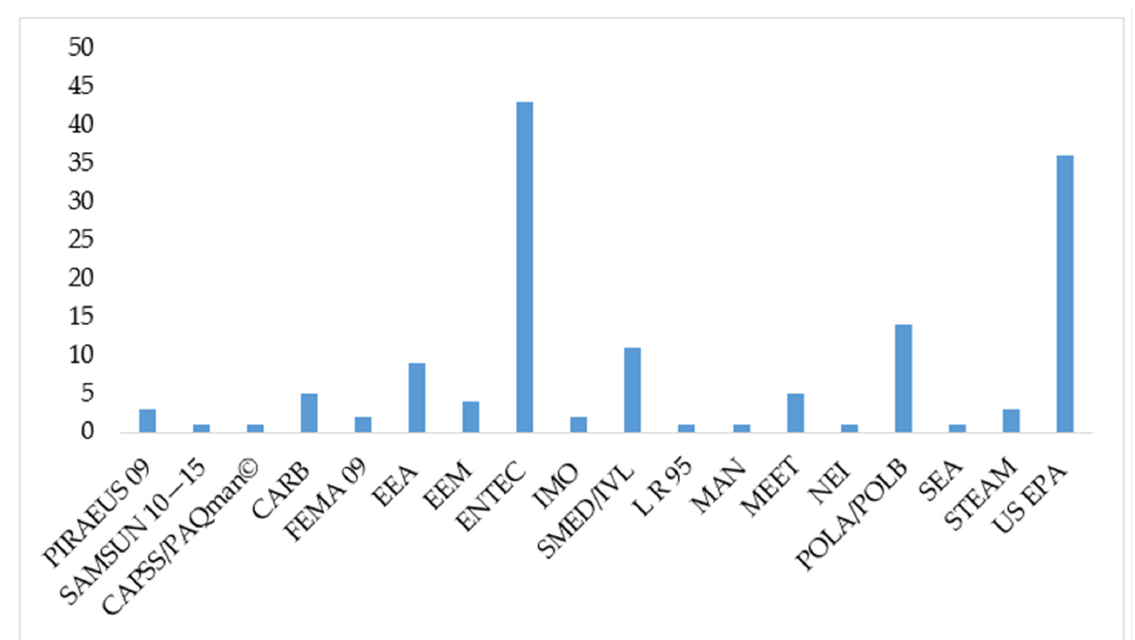
Figure 3. Citation quantity overview of methodologies and datasets originated from the papers and studies that explored ship emissions estimation.